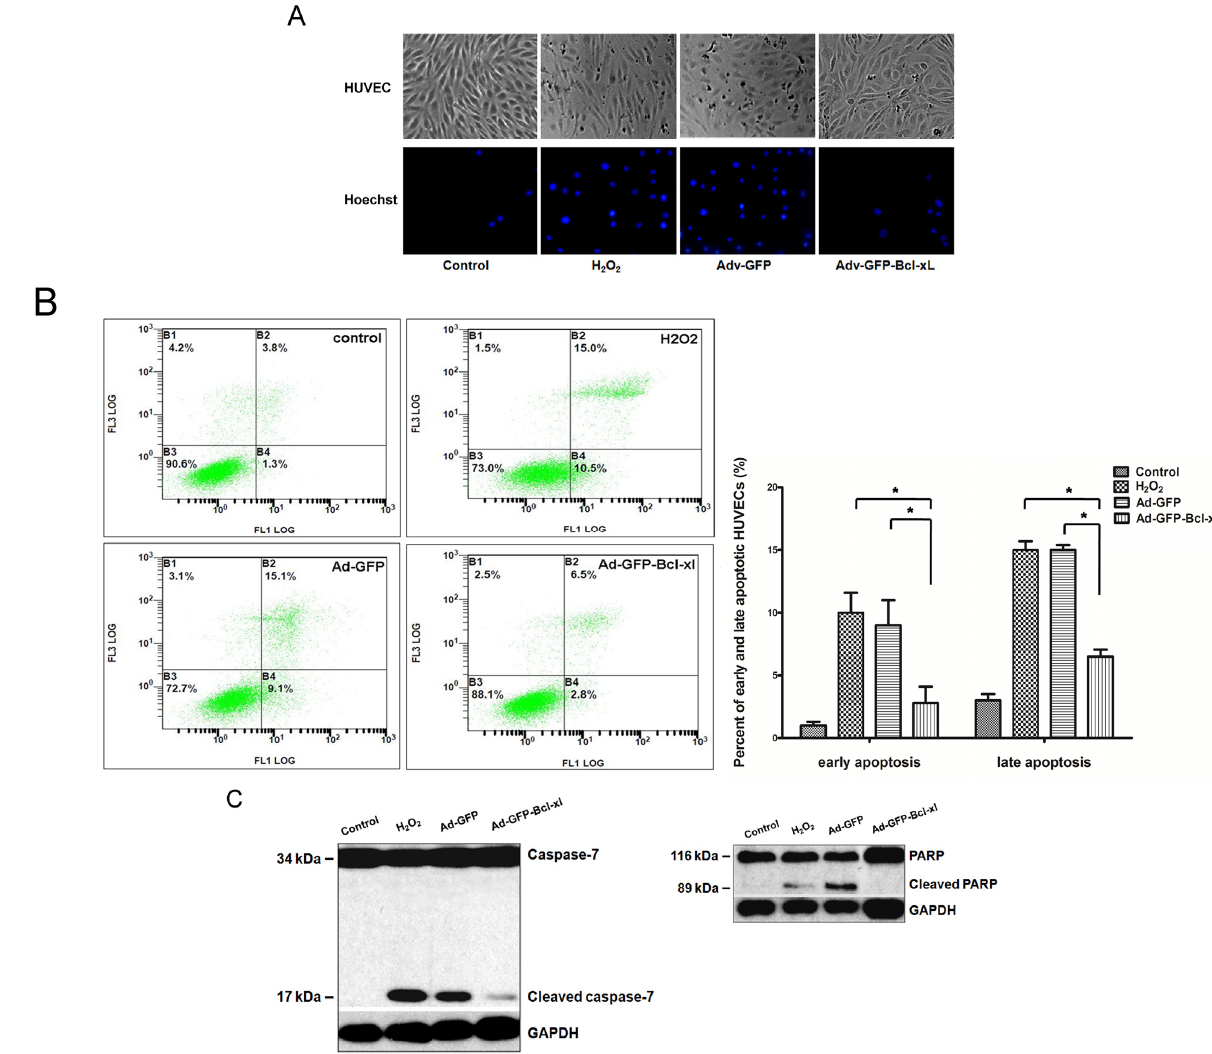
Figure 2. Evaluation of cell apoptosis level in each group. After being infected with Adv-GFP- Bcl-xl (or Adv-GFP) of 100 MOI for 48 h, HUVECs were subsequently stimulated with 0.5 mM H O for 12 h. ( A ) Observation of cell morphological changes 2 2 under microscope (×40) and nuclear staining with Hoechst 33,258 (×100); ( B ) Analysis of HUVEC apoptosis through Annexin V-fluorescein isothiocyanate/propidium iodide(Annexin V-FITC/PI) flow cytometry. The proportion (%) of the cell number is shown in each quadrant. The proportion of viable cells was shown in the B3 quadrant (FITC − /PI − ). Early apoptotic cells are shown in the B4 quadrant (FITC+/PI − ), and late apoptotic/necrotic cells are shown in the B2 quadrant (FITC+/PI+); ( C ) Western blot analysis of the apoptotic-related proteins, caspase-7 and PARP, in HUVECs. Control: O : HUVECs exposed to 0.5 mM H O ; Adv-GFP: HUVECs normal HUVECs; H 2 2 2 2 pretreated with empty virus and then exposed to 0.5 mM H O ; Adv-GFP- Bcl-xl : HUVECs 2 2 pretreated with Adv-GFP- Bcl-xl and then exposed to 0.5 mM H O . Data are representative 2 2 of the means ± the standard error of the mean (SEM) ( n = 6). Statistical analysis was performed using one-way analysis of variance (ANOVA), followed by Tukey’s multiple comparison test ( * p <